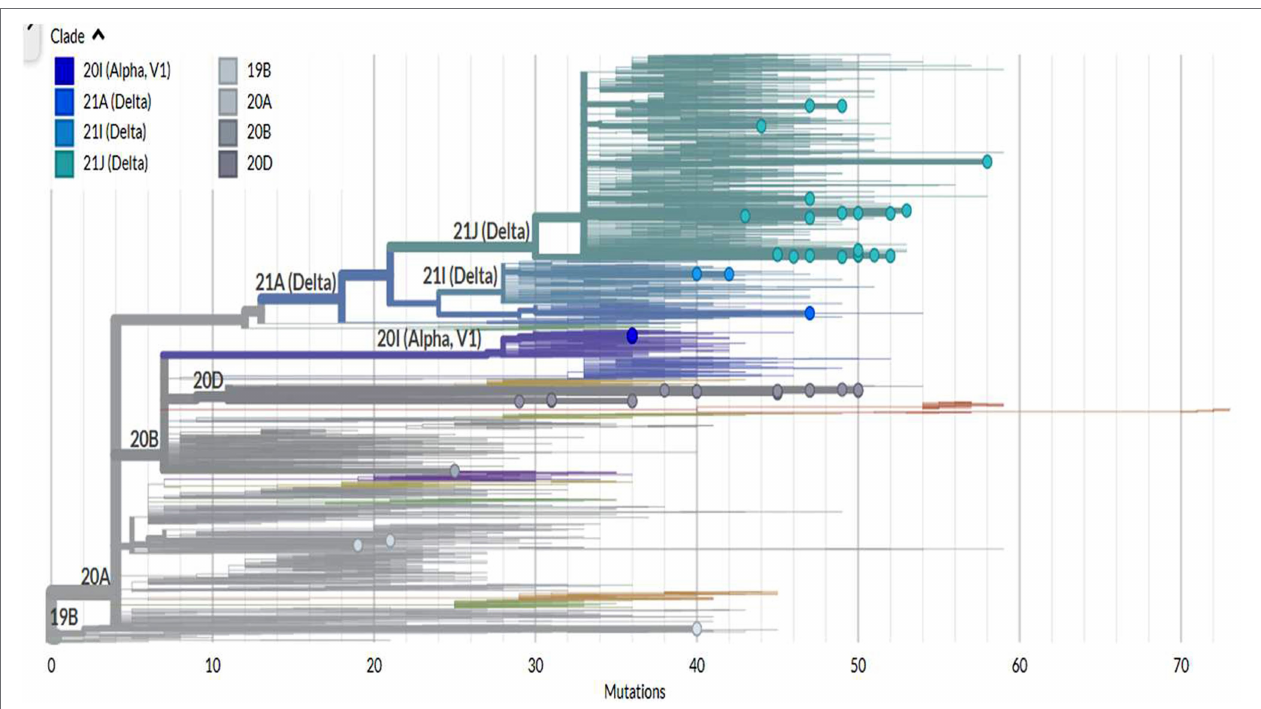
FIGURE 2 | Rectangular phylogenetic tree showing the distribution of sequences among different clades